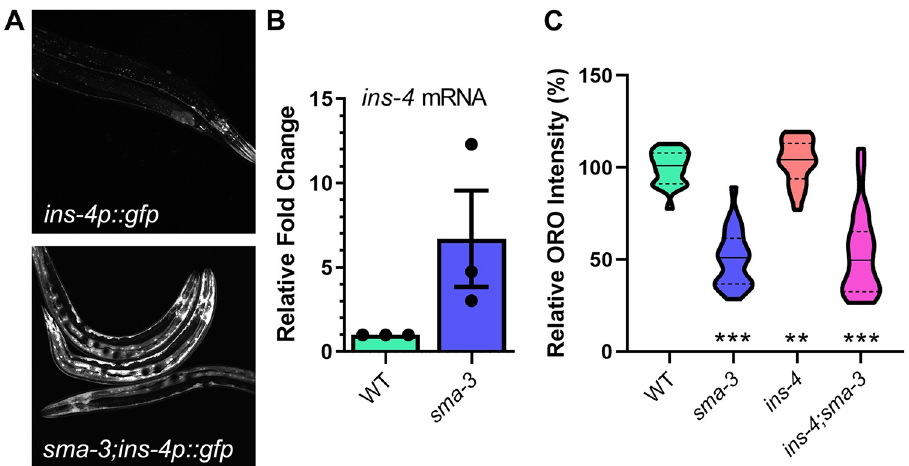
Fig 1. INS-4 acts downstream of SMA-3 and regulates lipid metabolism. A) Images of animals expressing ins-4p :: GFP. Control animals displayed ins-4p ::GFP in head neurons, with faint expression in the hypodermis. Upon loss of sma-3 , ins-4p ::GFP expression is significantly increased in the hypodermis. Images taken at 200X, camera settings were kept constant between all strains. B) Relative quantification of ins-4 mRNA expression in sma-3 mutants compared to control animals via RT-PCR. C) Loss of ins-4 results in an increase in intestinal lipid stores via Oil Red O staining. Animals were grown at 20˚C and stained at the L4 larval stage. Quantification was done for equivalent regions of the intestine just posterior to the pharynx. For all graphs, asterisks across the bottom denote significance compared to Control, n.s. not significant, � p value < 0.05, �� p value < 0.01, ��� p value < 0 .001, solid lines denote the median, dashed lines denote